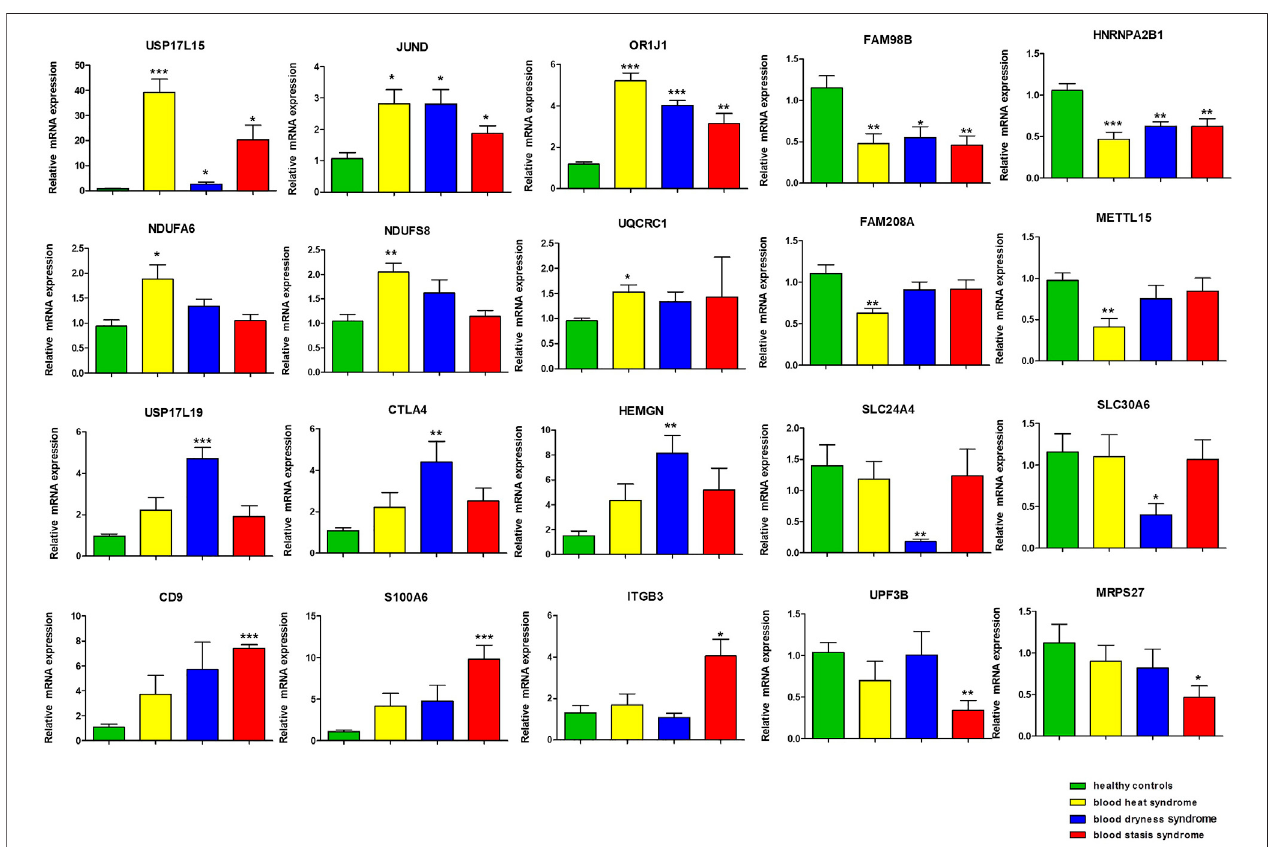
FIGURE4| ThegenevalidationbyqRT-PCR.(* p < 0.05,** p < 0.01,*** p < 0.001inqRT-PCRveri fi cationwhencomparingdatabetweendifferentsyndromegroups and healthy control group).